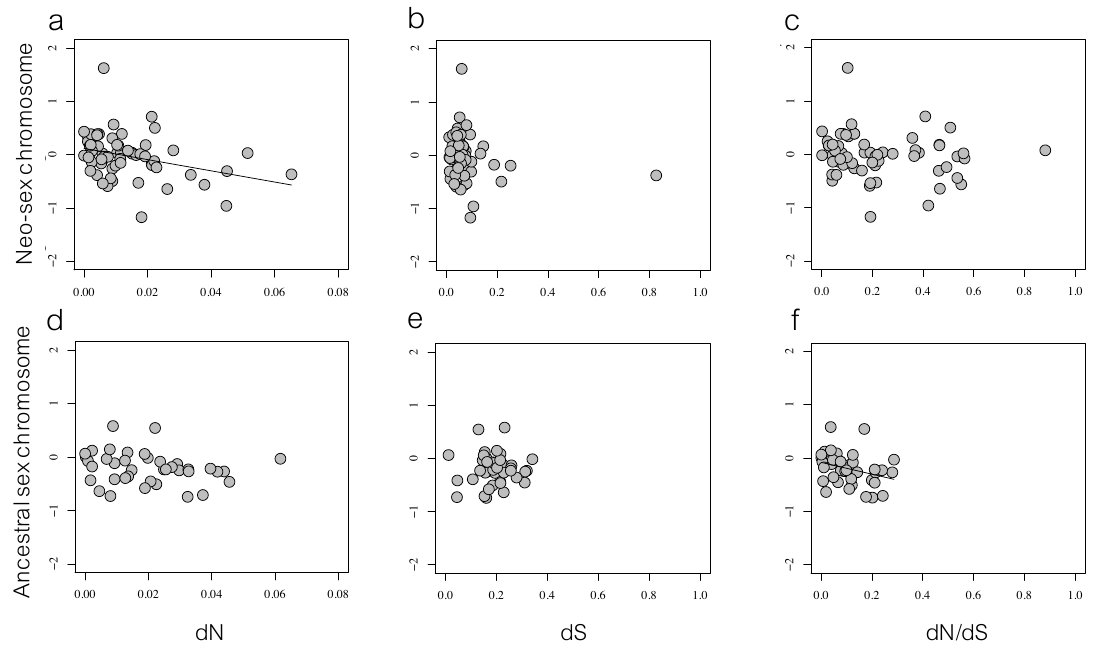
Figure 5. Association between female-to-male gene expression ratio and degree of sequence divergence (dN, dS and dN/dS) for common whitethroat gametologs on the neo-sex chromosome ( a – c ) and on the ancestral sex chromosome ( d – f ). Lines indicate significant correlations (( a ) p = 0.009; ( f ) p =